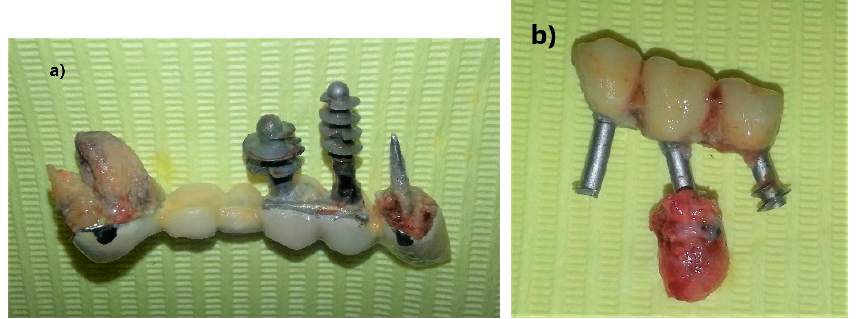
Figure 3. ( a ) Extracted upper fixed restoration; ( b ) extracted lower fixed restoration.